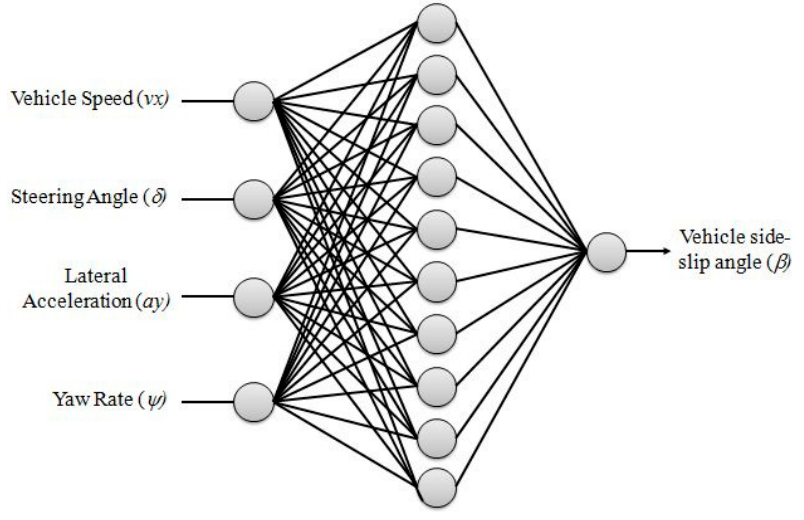
Figure 4. General layout of an ANN used for vehicle sideslip angle (VSA) estimation.